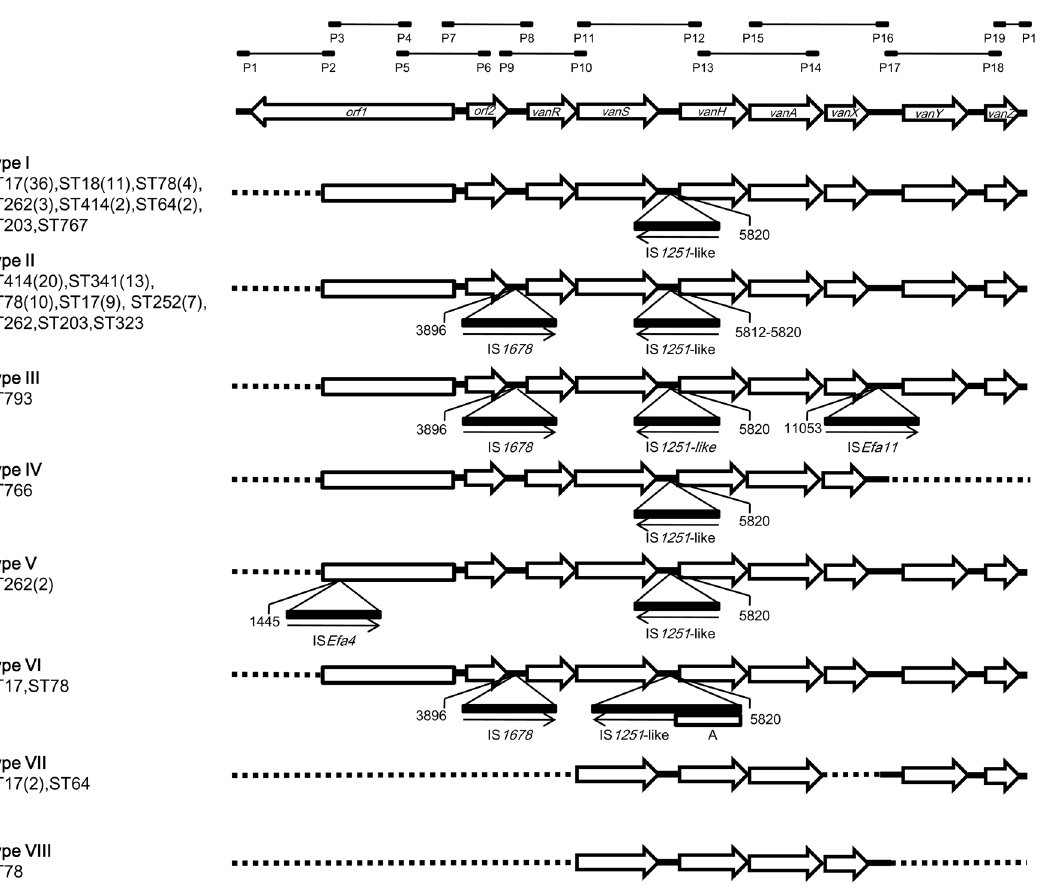
Fig. 3. Genetic maps of Tn 1546 structures found among the 132 van A-containing VRE isolates studied. Primers (P1– P19) used were based on the scheme described by Arthur et al. [25]. The positions of genes and open reading frames and the direction of transcription are depicted with open arrows. IS elements are indicated by triangles. The positions of the nucleotide upstream to the IS insertion sites are depicted. Arrows under the triangles indicate the transcriptional orientations of the inserted IS elements. Dotted lines indicate no amplicon by the corresponding primers. A, an extra DNA sequence inserted without further characterization. STs carrying those structure types are indicated to the left of the maps, respectively. Numbers of isolates are indicated in parentheses if more than one was found.